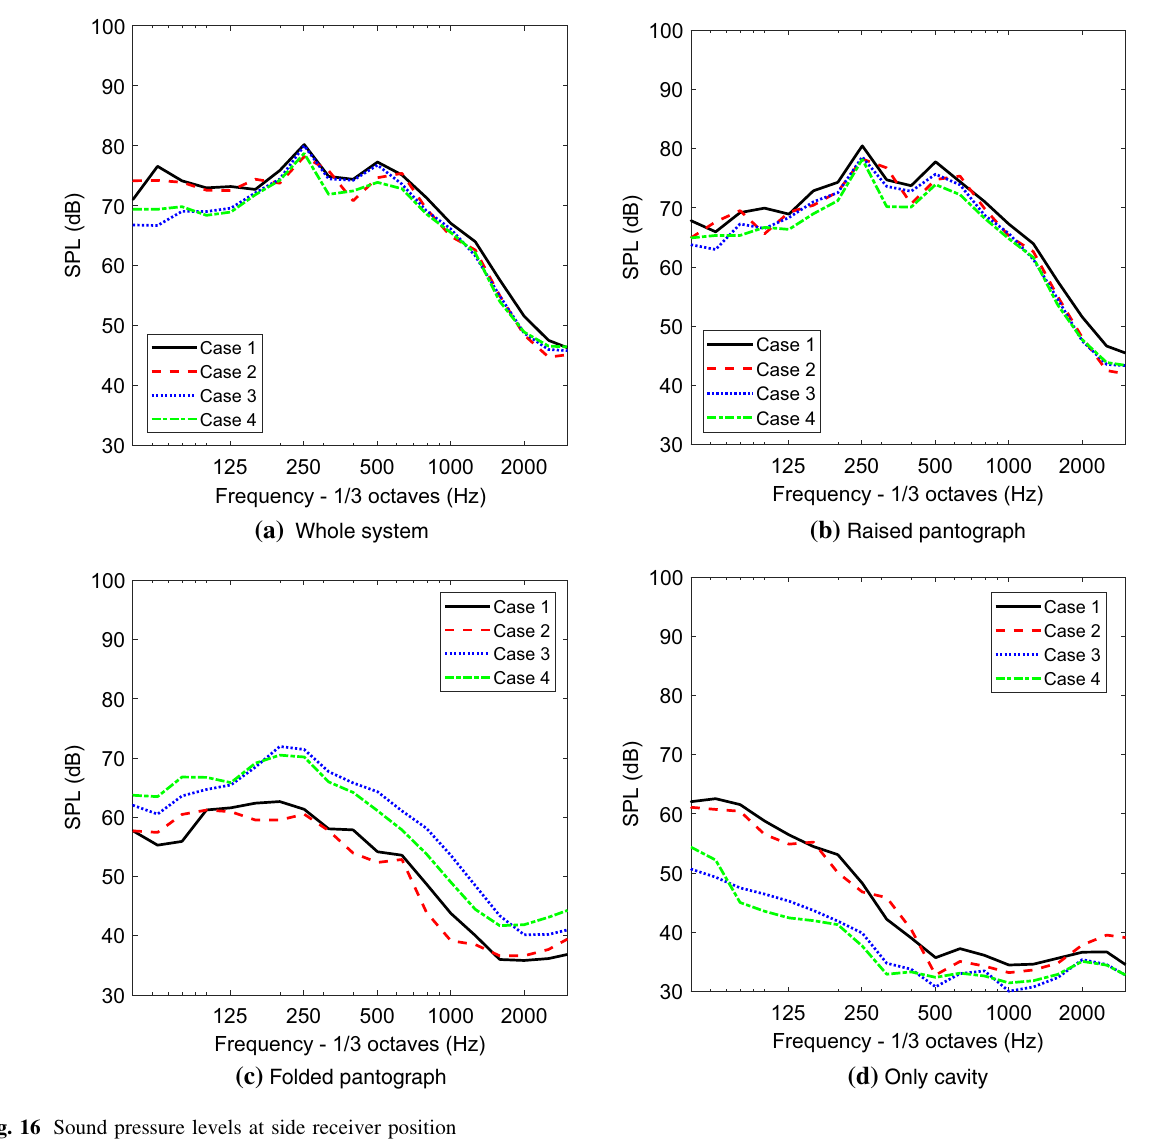
Fig. 16 Sound pressure levels at side receiver